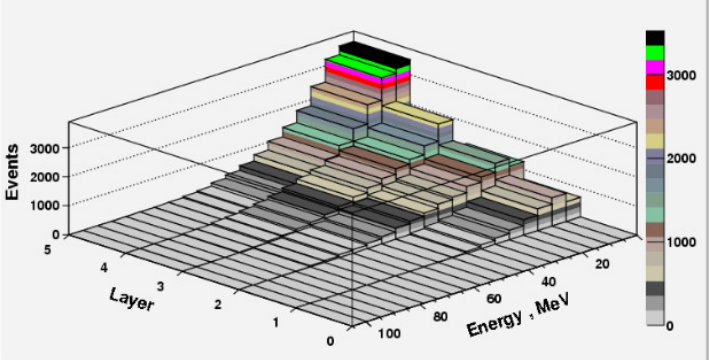
running. Depending on the length of the flight and the arrival time of the signal from the interaction to the counter, it is possible to estimate the velocity and the energy of the neutron. The energy distribution of neutrons in each layer of the detector is shown in Fig. 5. The neutrons interact continuously in all layers. The number of events in each layer depends on the position of layer. Each next layer detects the products of neutron interaction in all previous layers. It can be seen that the probability of interaction increase from layer to layer and after interaction the neutron with the proton of material these secondary protons have forward direction.